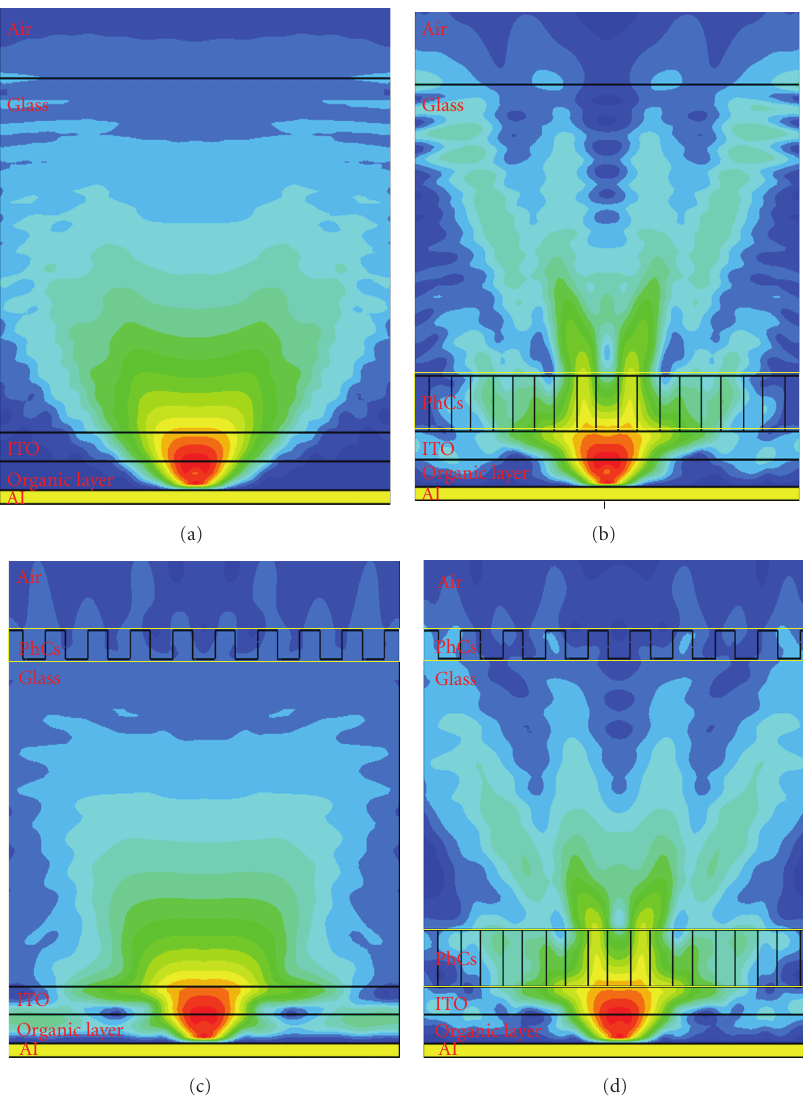
Figure 14: The vertical power distribution of (a) ordinary OLEDs, (b) OLEDs with embedded PhCs, (c) OLEDs with surface PhCs, and (d) OLEDs with embedded PhCs and surface PhCs. The region in the yellow rectangle is the PhCs layer.